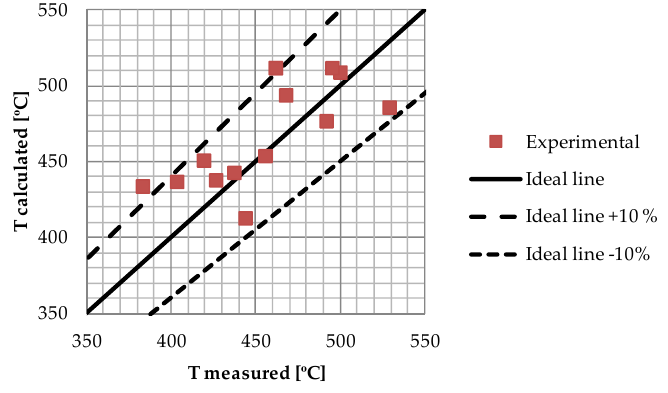
Figure 5. Calculated vs. measured operating temperatures, at position T 5 (Figure 3).